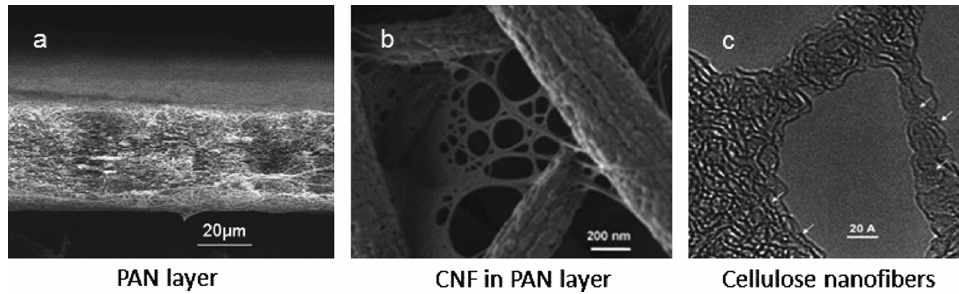
* Not only Cu(II), but also Fe(III) and Ag(I) have been investigated in [142], but in the present review only heavy metal ions, dangerous as reported in Table 2, were considered.